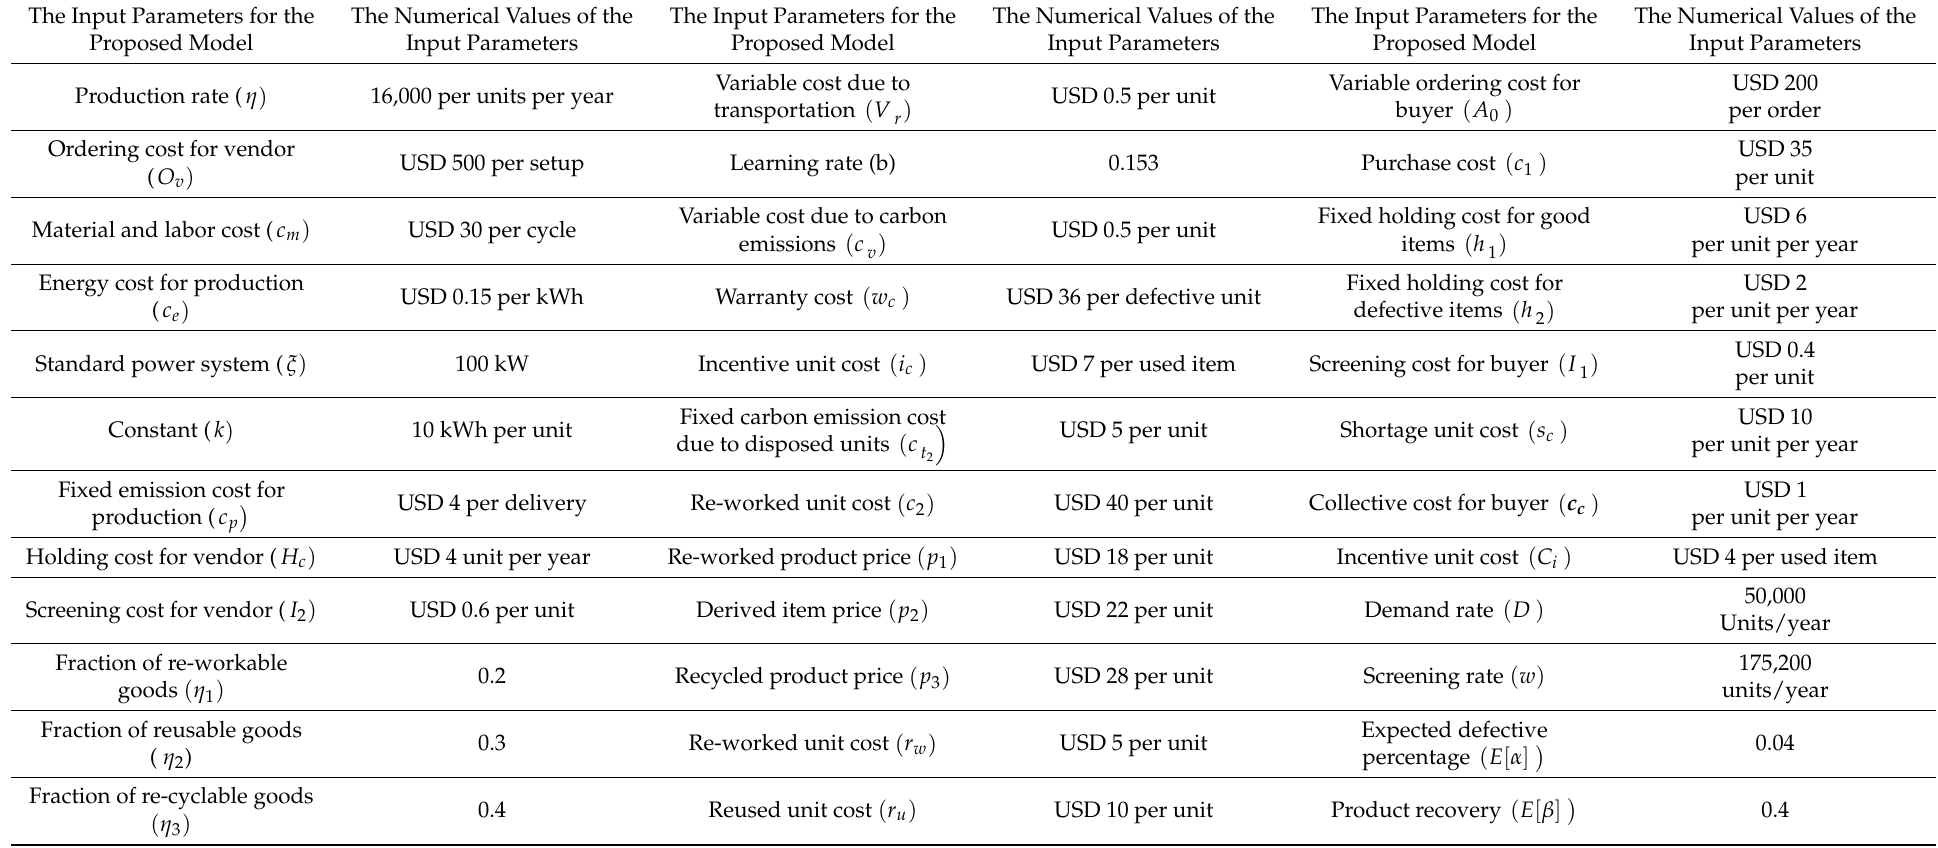
Table 2. Input parameter values used in the proposed